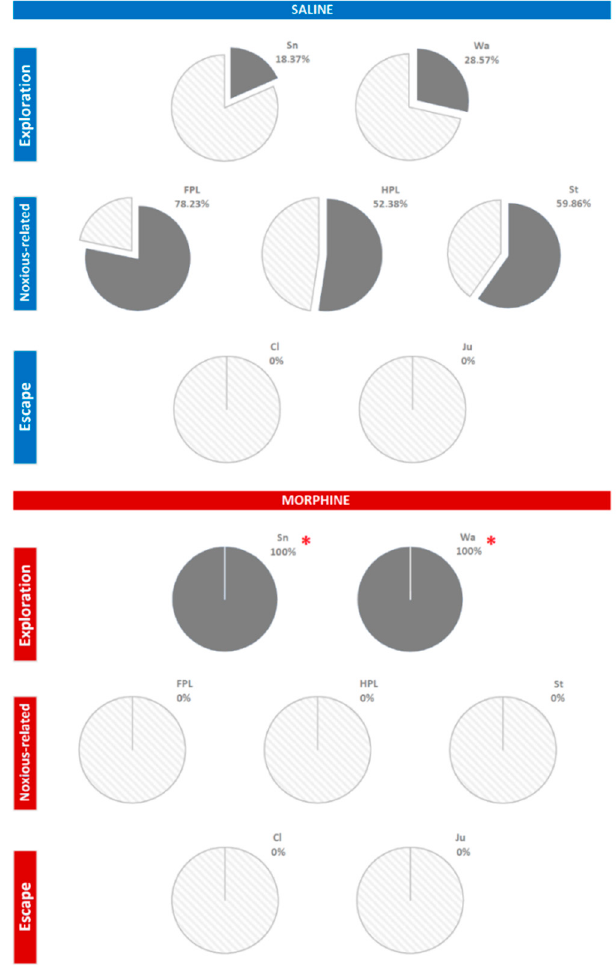
Figure 6. Pie charts indicating the percent of T-patterns containing each component of the behavioral repertoire. * = significant ( p < 0.0001) difference between morphine and saline, as assessed by the Fisher’s exact probability test. Data obtained from the analysis of two groups each encompassing 10 subjects. For abbreviations, see Figure 1.